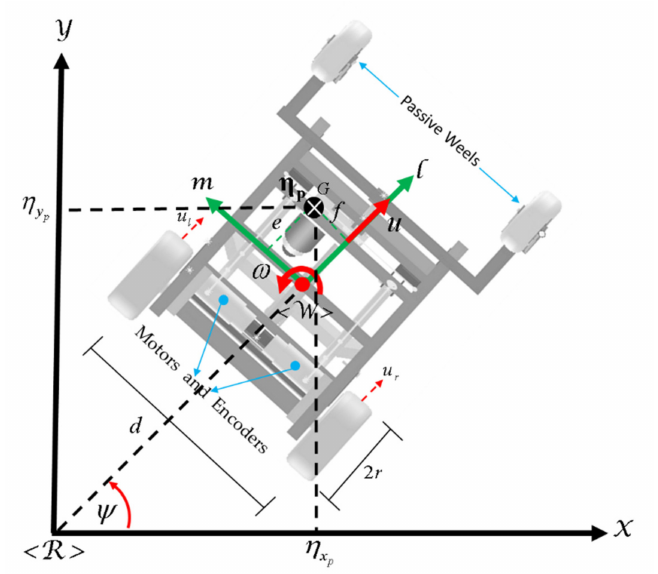
Figure 2. Schematic of the robotic